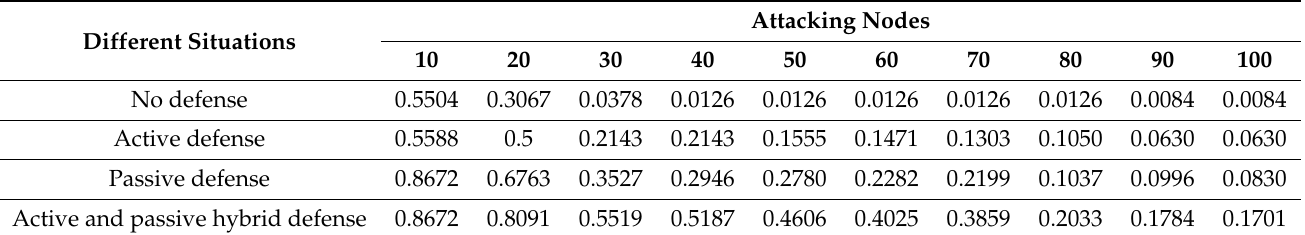
Table 5. The propotion of survival